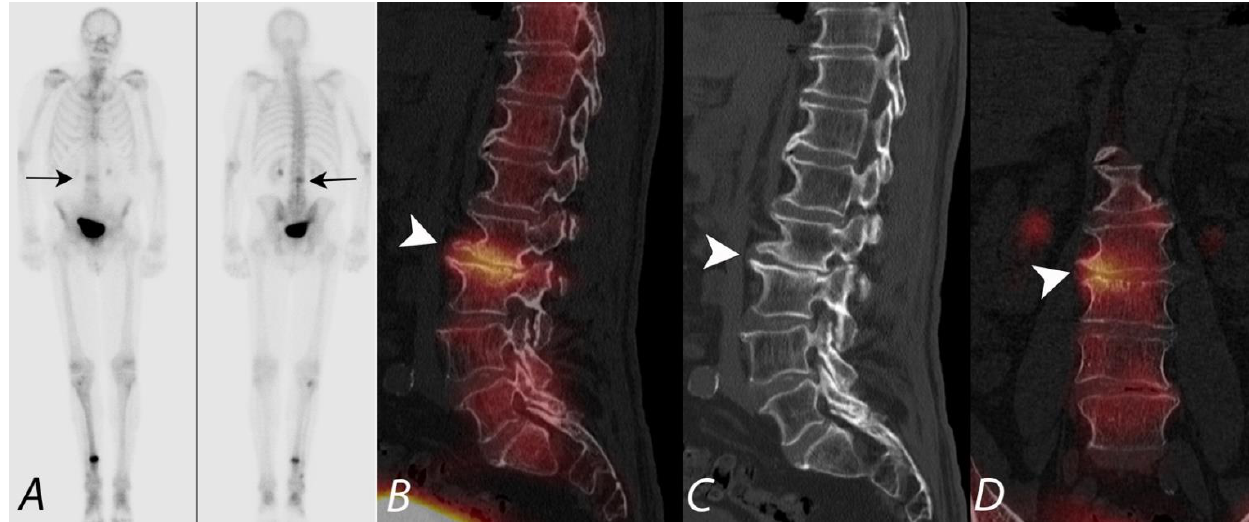
Figure 4. Anterior and posterior planar images ( A ) from a 99m Tc MDP bone scan on a patient with prostate cancer being evaluated for metastatic disease, with focal uptake along the right aspect of lumbar spine (black arrows). Additional focus of uptake involving the distal right tibia is related to a known fracture involving this region. No additional foci of uptake concerning metastatic disease were identified. Sagittal CT image and fused SPECT/CT images in sagittal and coronal projections ( B – D ) localize the activity to the right aspect of the disc space between L2 and L3, correlating with disc space narrowing and osteophytosis (white arrowhead). Findings are consistent with uptake related to degenerative disc disease and not related to metastatic disease.